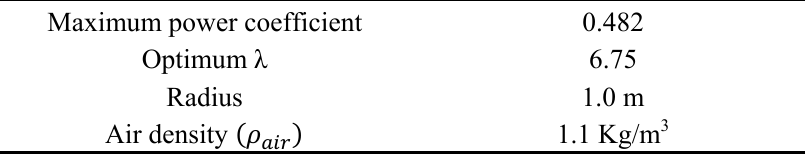
Table 1. Main characteristics of the wind